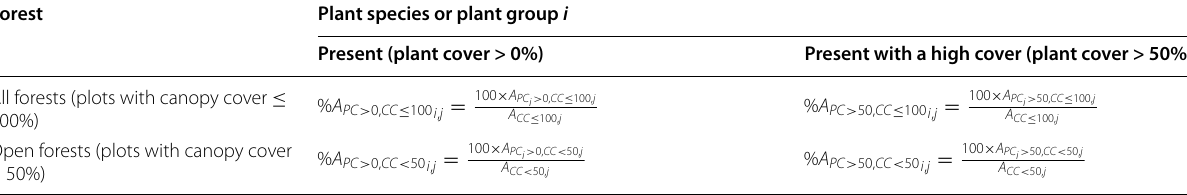
Table 2 Four indicators of the frequency of the vegetation control operations required for understory species, based on the forest area estimates defined in Table 1. In the following formulas, i corresponds to the plant species or group and j to the region Forest Plant species or plant group i Present (plant cover > 0%)